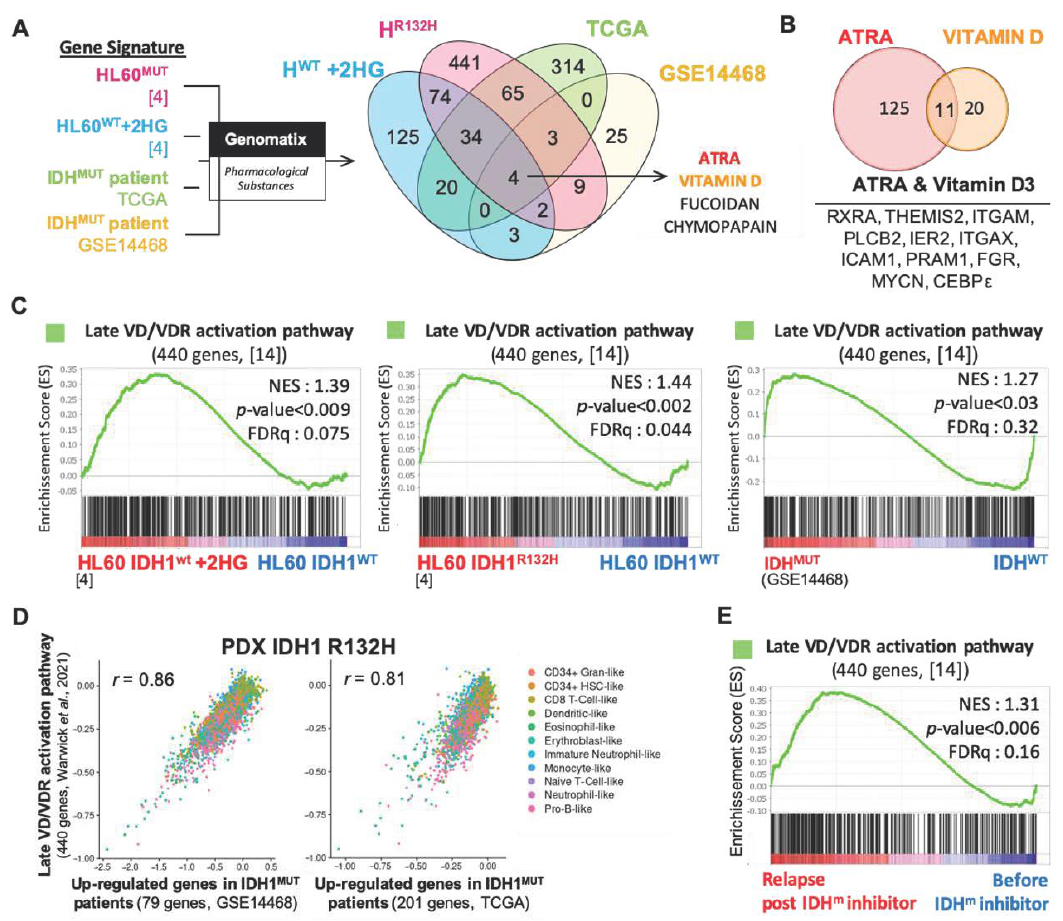
Figure 1. Vitamin D receptor-related gene signatures are enriched in transcriptomes of IDH mutant AML cells. ( A ) Gene signature of pharmacological substances were compared with gene signatures associated with IDH1 MUT HL60 cells, IDH1 WT HL60 cells+2HG and IDH MUT patient cells from TCGA and GSE14468 transcriptomes using Genomatix software. VENN diagram represents common pharmacological substances associated with these four gene signatures. ( B ) VENN diagram of common genes from ATRA- and VD-responsive genes (Pharmacological substances, Genomatix) enriched in IDH MUT -AML and HL60 IDH1 WT +2HG. ( C ) Gene set enrichment analysis (GSEA) of late VD/VDR activation pathway signature in HL60 IDH1 R132H , HL60 IDH1 WT treated with 2HG and in IDH MUT patients from GSE14468. ( D ) Correlation between late VD/VDR activation pathway gene signature and up-regulated genes in IDH1 MUT signatures (left, GSE14468; right, TCGA) in scRNA-seq of AML cells from the PDX IDH1 R132H . ( E ) GSEA of late VD/VDR activation pathway gene signature